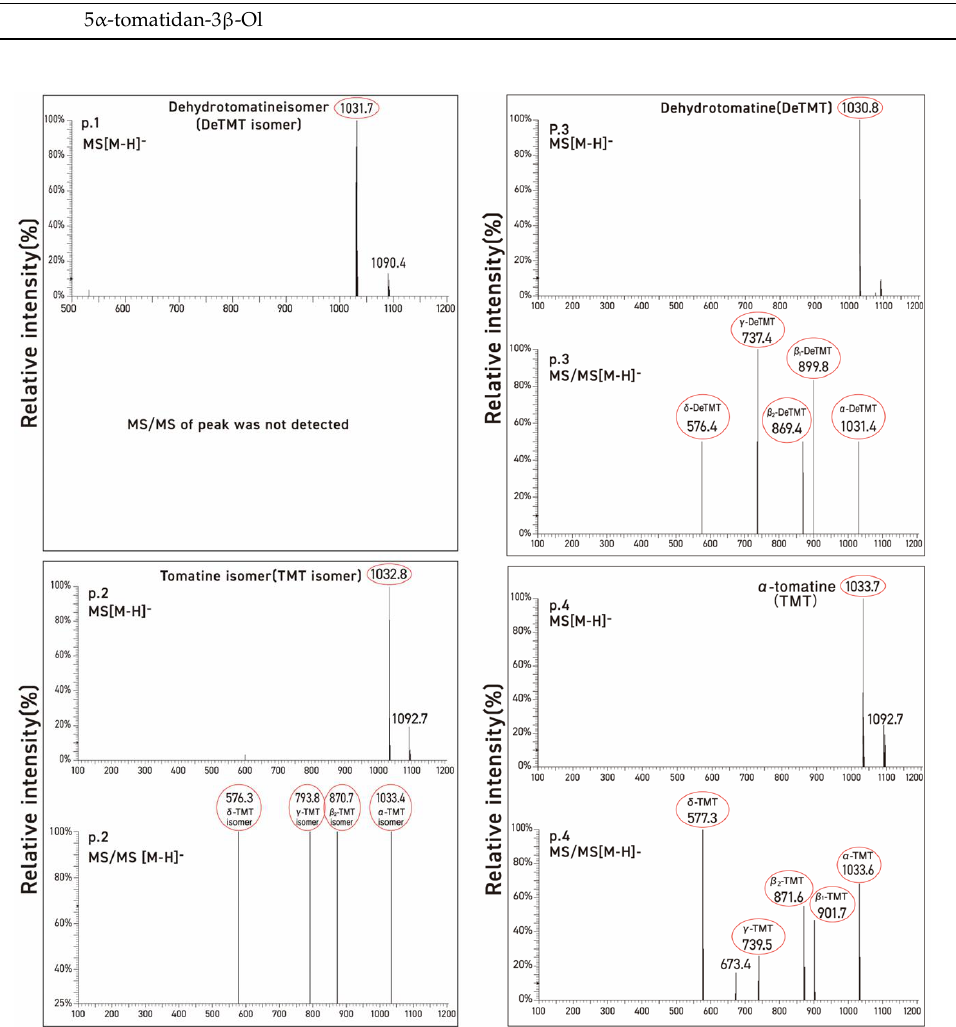
Figure 5. Mass and MS/MS spectra of each of the four peaks obtained from commercial α-tomatine by LC-MS. The protonated, negatively charged molecular ion peaks are designated by [M-H] − .